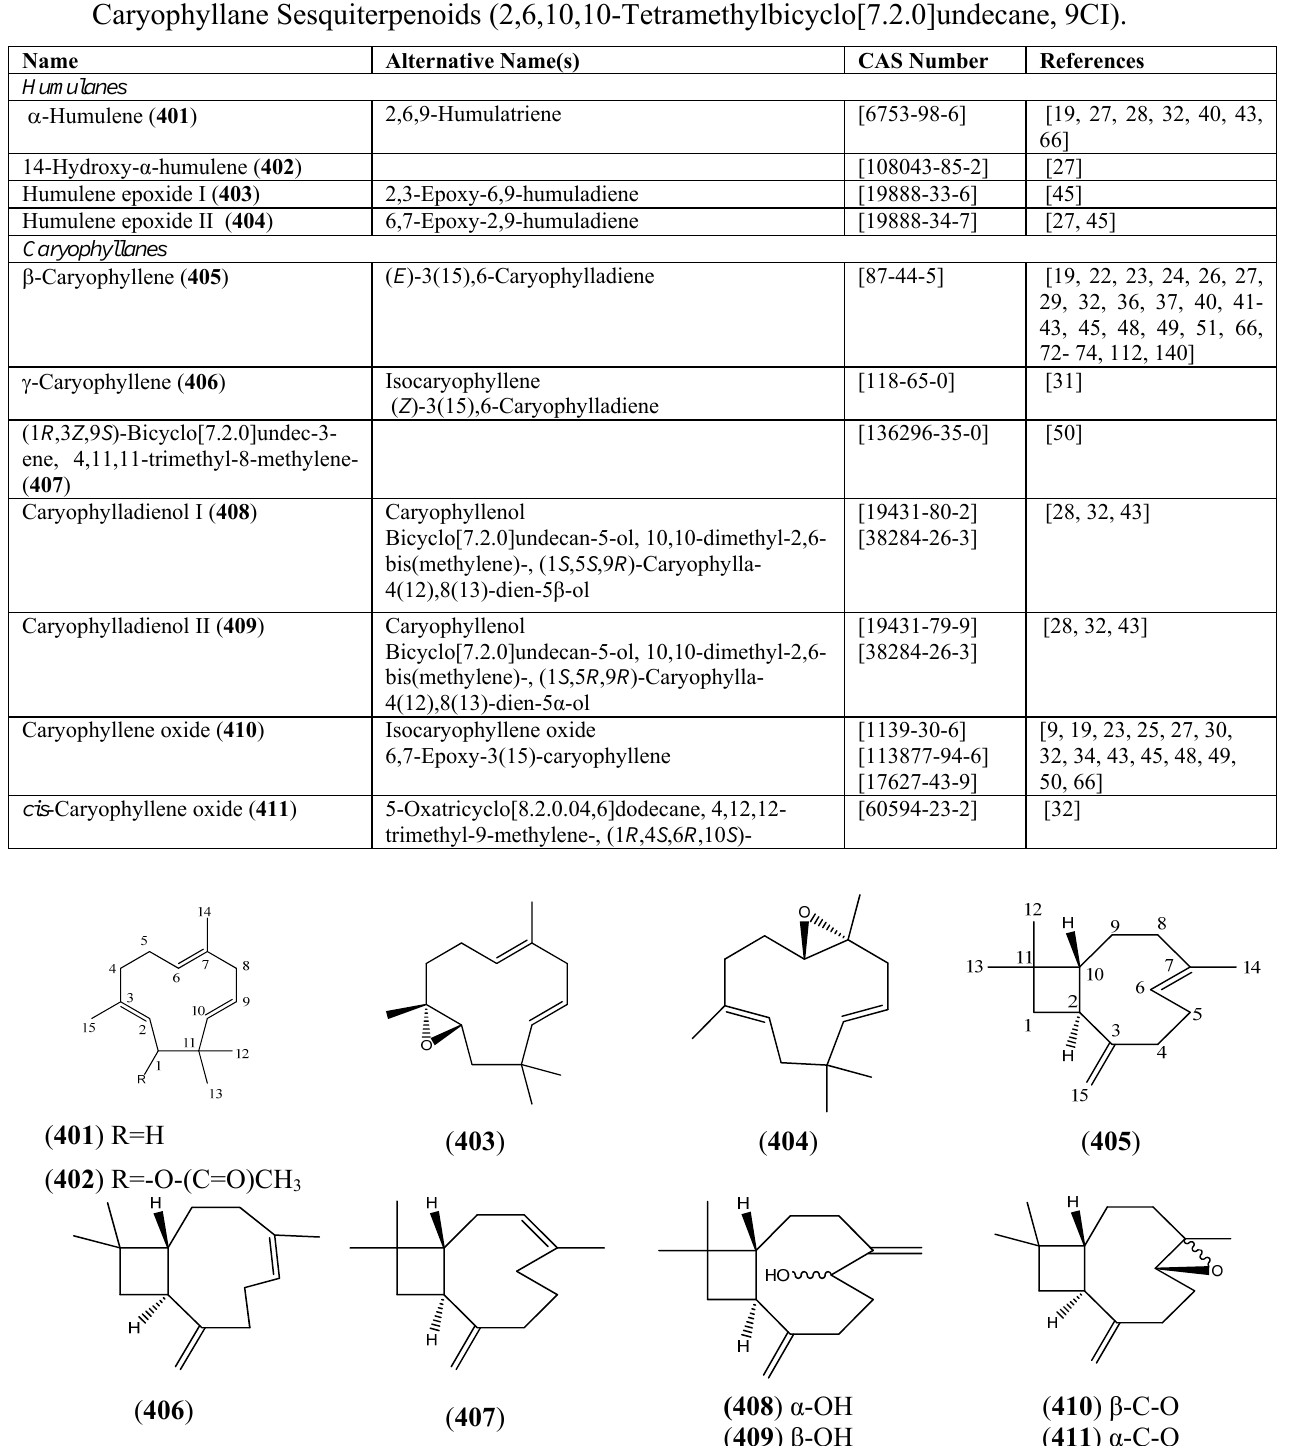
Table 33. Humulane Sesquiterpenoids (1,1,4,8-Tetramethylcycloundecane, 9CI)